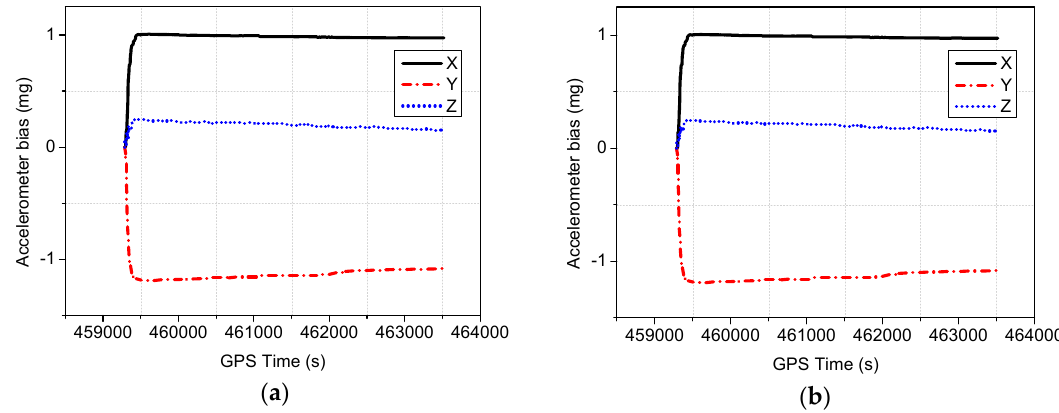
Figure 15. Estimated accelerometer bias and gyroscope bias for the test. ( a ) Accelerometer bias; ( b ) Gyroscope bias.